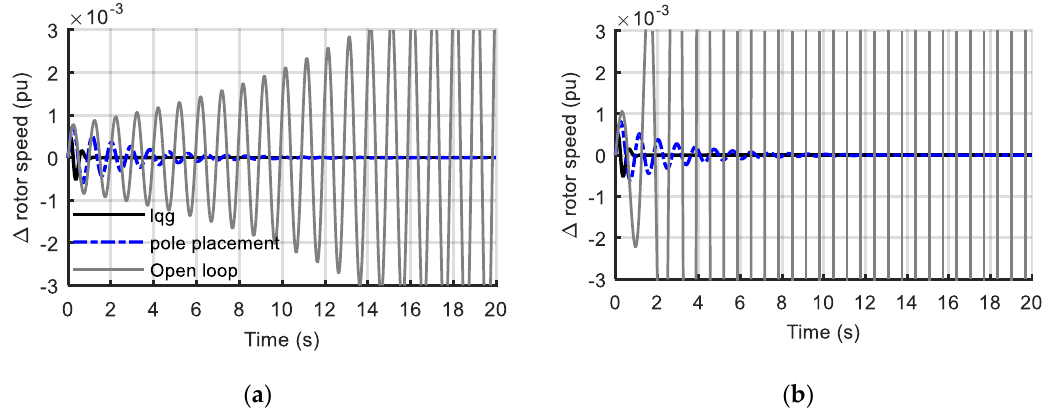
Figure 6. SG rotor speed deviations due to 0.05 pu step load demand at lead power factor. ( a ) At P = 1 pu, Q = − 0.25 pu; ( b ) At P = 1 pu, Q = − 0.8 pu.